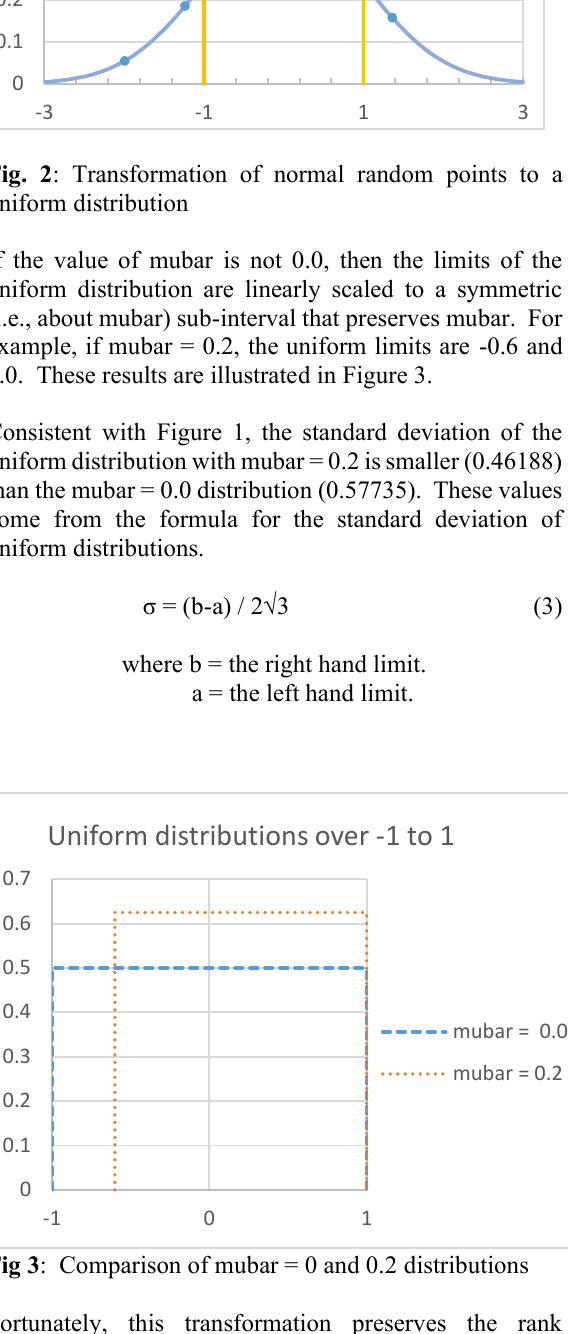
Fig 3 : Comparison of mubar = 0 and 0.2 distributions Fortunately, this transformation preserves the rank correlation (e.g., the largest and smallest points are still at their same locations in the vector) of the randomly sampled points – though it does not exactly preserve the linear correlation between the mubar data samples. However, the transformed samples all fit inside the allowed interval and the average group value of mubar is preserved.